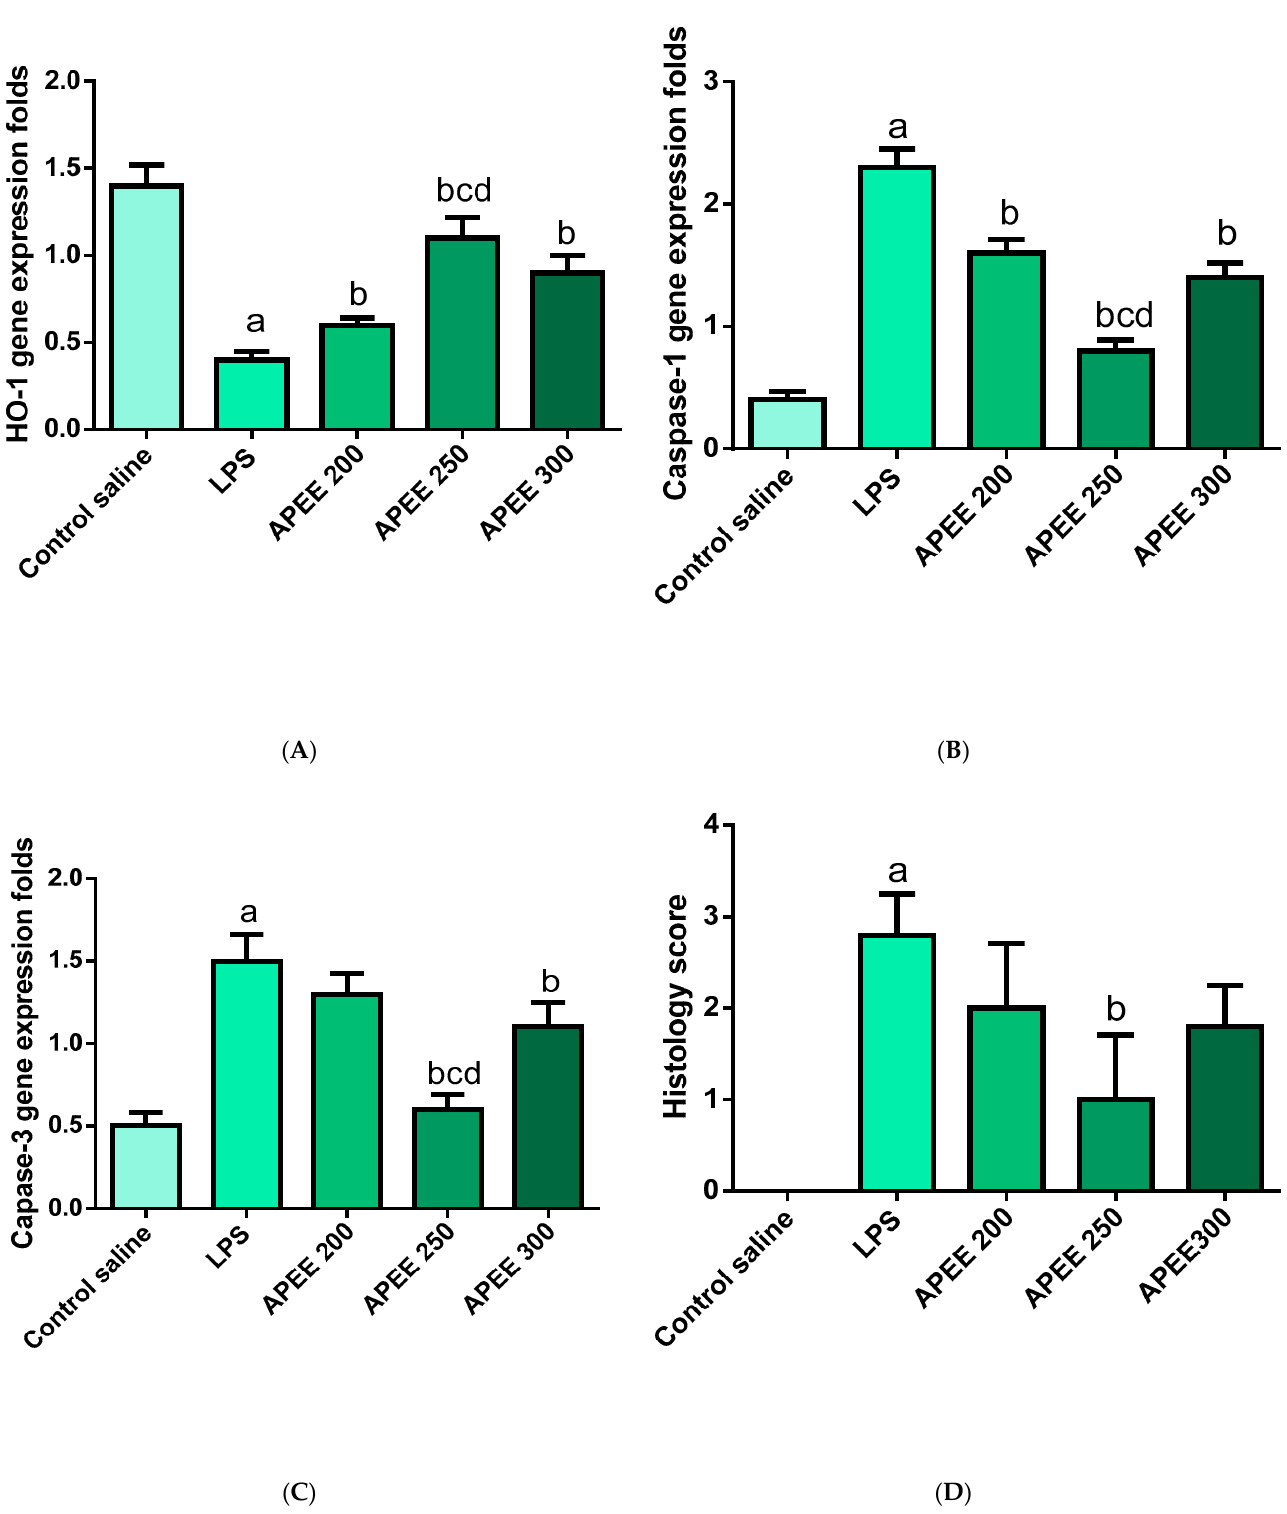
Figure 7. Impact of APEE pre-treatment on ( A ) HO-1 expression level, ( B ) Caspase-1 expression level ( C ) Caspase-3 expression level, ( D ) Lung Histology score. Acute lung injury was urged by I.P. injection of LPS (10 mg/kg). APEE 200, 250, and 300 were given I.P. 30 min before LPS injection. Results were expressed as mean ± SD ( n = 10/group) as the experiments were performed in three independent triplicates. Significant difference vs. a respective control, b respective LPS group, c respective APEE 200 group, d respective APEE 300 group each at p < 0.05.